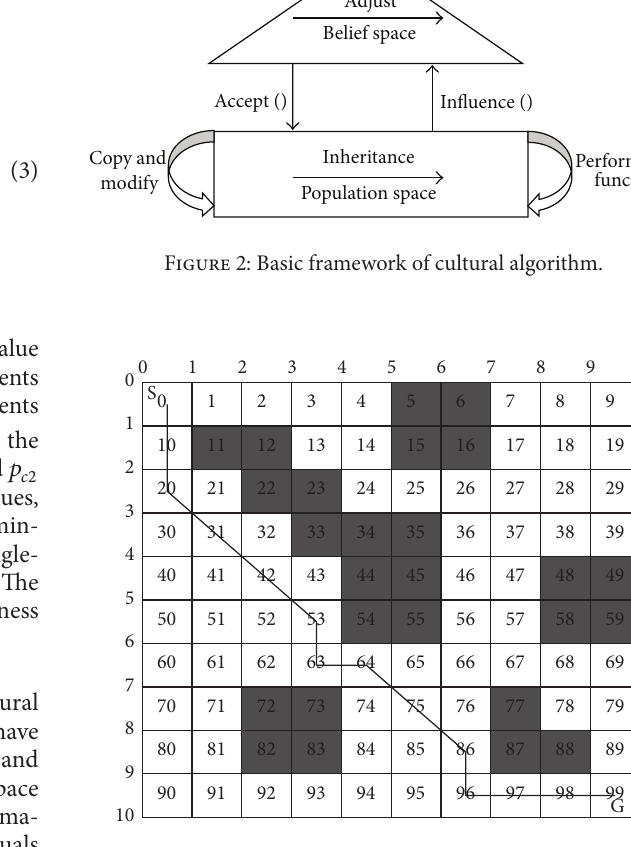
Figure 3: Original path